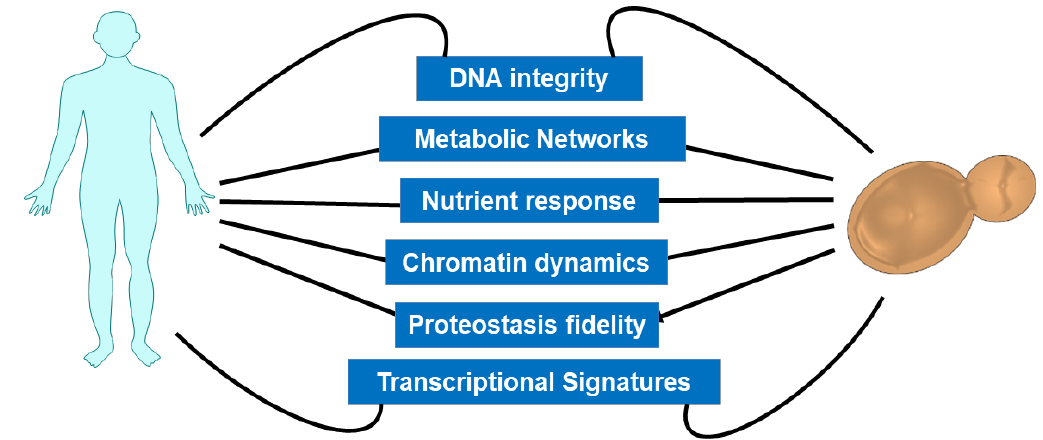
Figure 1. Conserved hallmarks of aging between yeast and humans. The conserved biological pathways known to modulate lifespan from yeast to higher eukaryotes are illustrated.